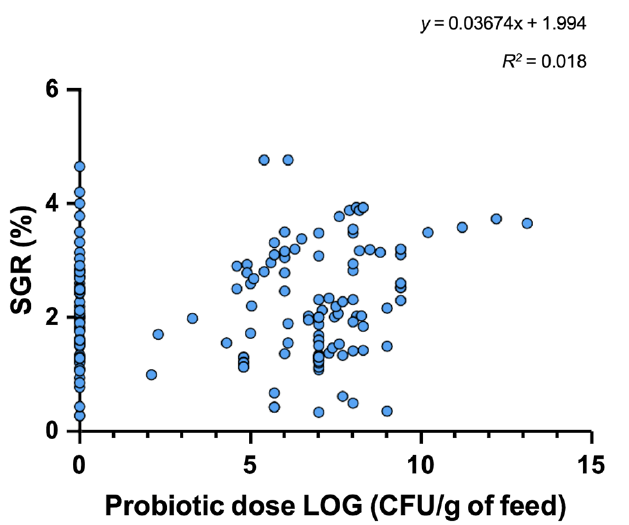
Figure 3. Data analysis revealed no significant correlation between probiotic dose in feed and SGR in fish. The circles represent the mean of experimental groups (n = 3; either control group or probiotics treatment group) tested in the studies considered for the regression analysis.